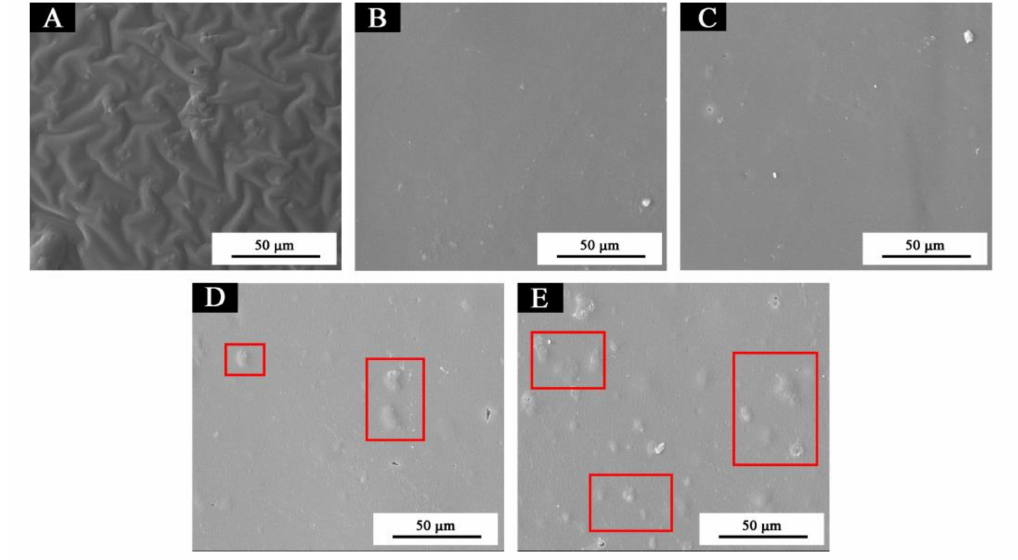
Figure 11. SEM of the waterborne coating with di ff erent coating processes: ( A ) thermochromic ink, ( B ) pure primer, ( C ) pure topcoat, ( D ) three-layer primer, three-layer topcoat and thermochromic ink